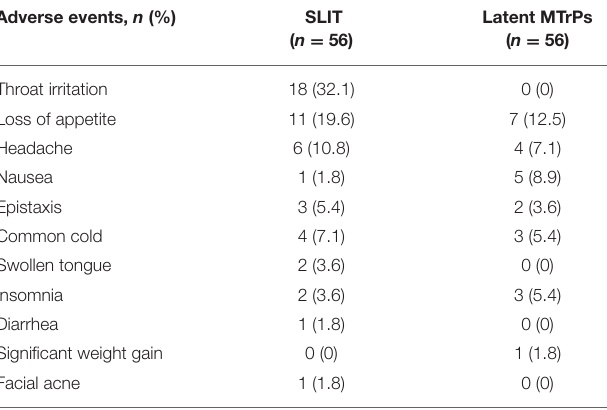
TABLE 2 | Change from baseline in nasal symptoms and TNSS. TABLE 3 | Treatment-related adverse